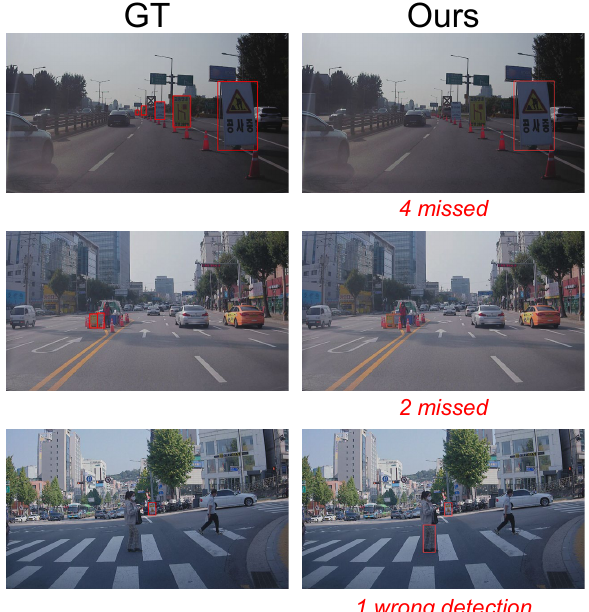
Figure 12. Limitations: if the construction sign is severely occluded, we cannot detect it accurately (first and second rows). A rectangle shape can be detected as a construction sign (third